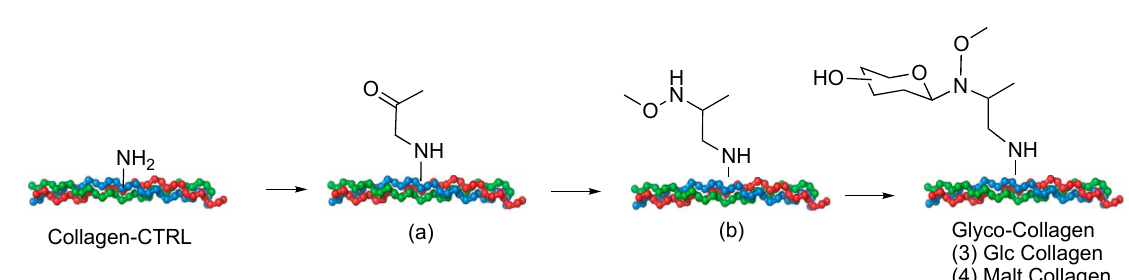
Figure 1. The general scheme of collagen neoglycosylation.